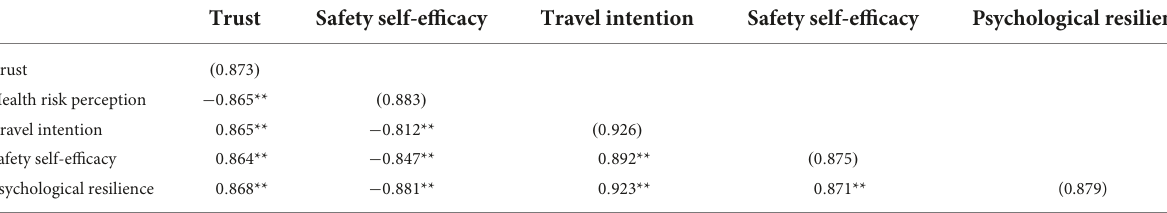
TABLE 2 Square root of average variance extracted (AVE) and correlation coefficients of latent variables.